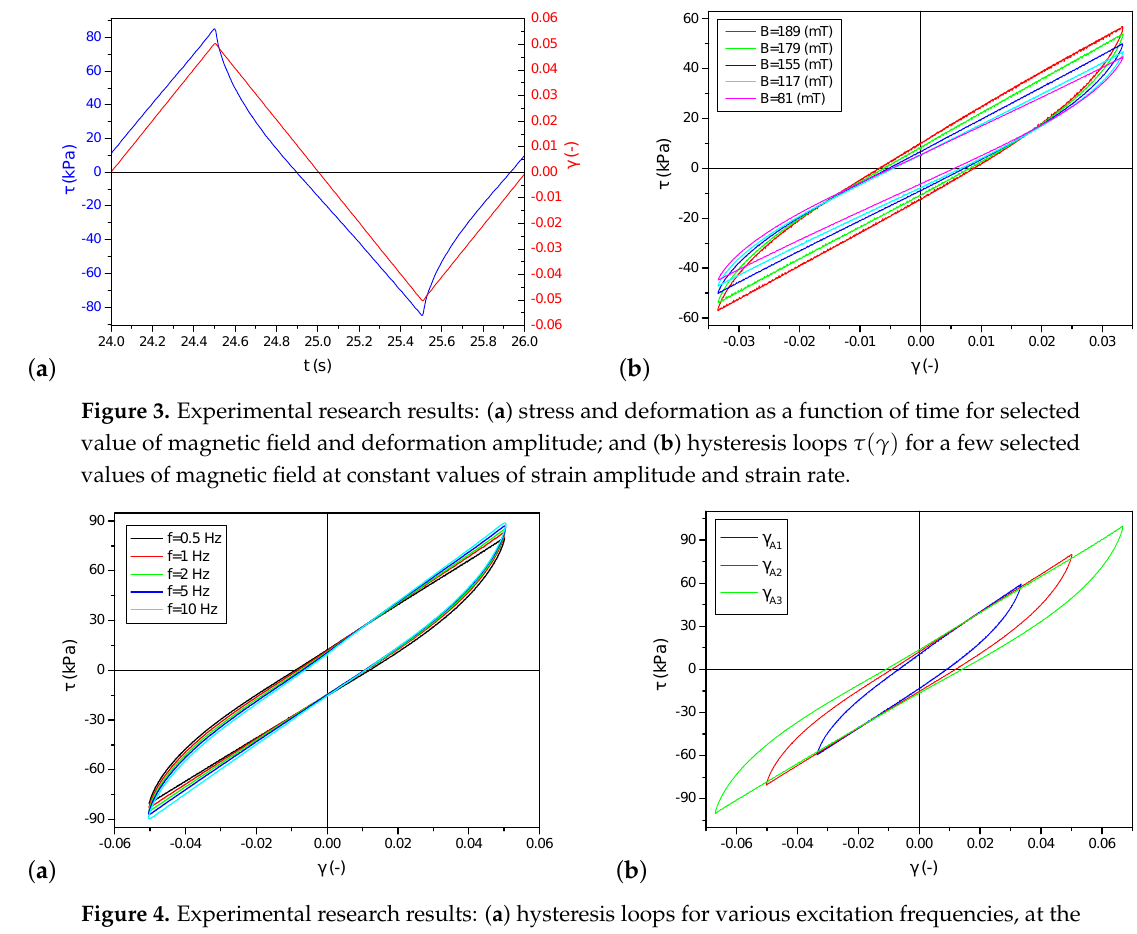
Figure 4. Experimental research results: ( a ) hysteresis loops for various excitation frequencies, at the selected value of magnetic field and deformation amplitude; and ( b ) hysteresis loops for different strain amplitudes, at the chosen value of magnetic field and deformation